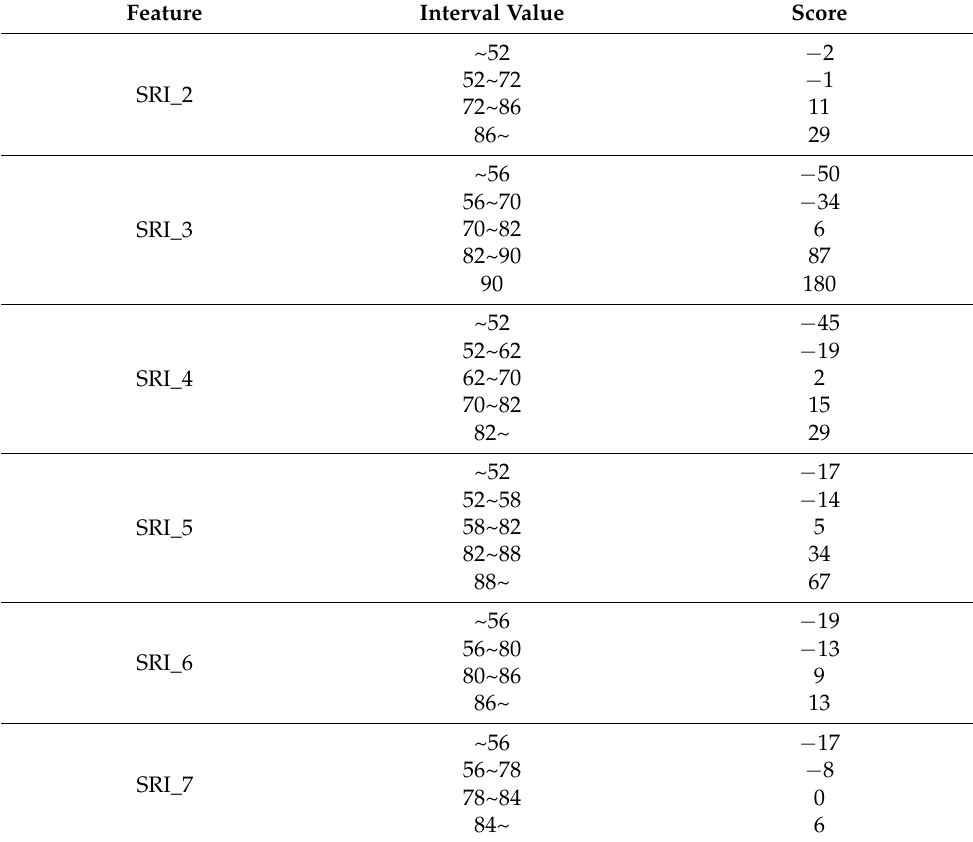
Table 6. Scorecard for each